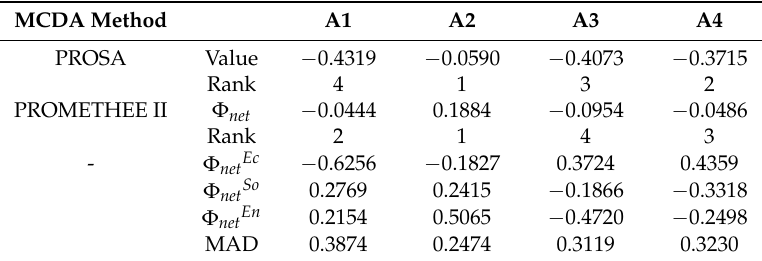
Table 6. The results of the multi-criteria